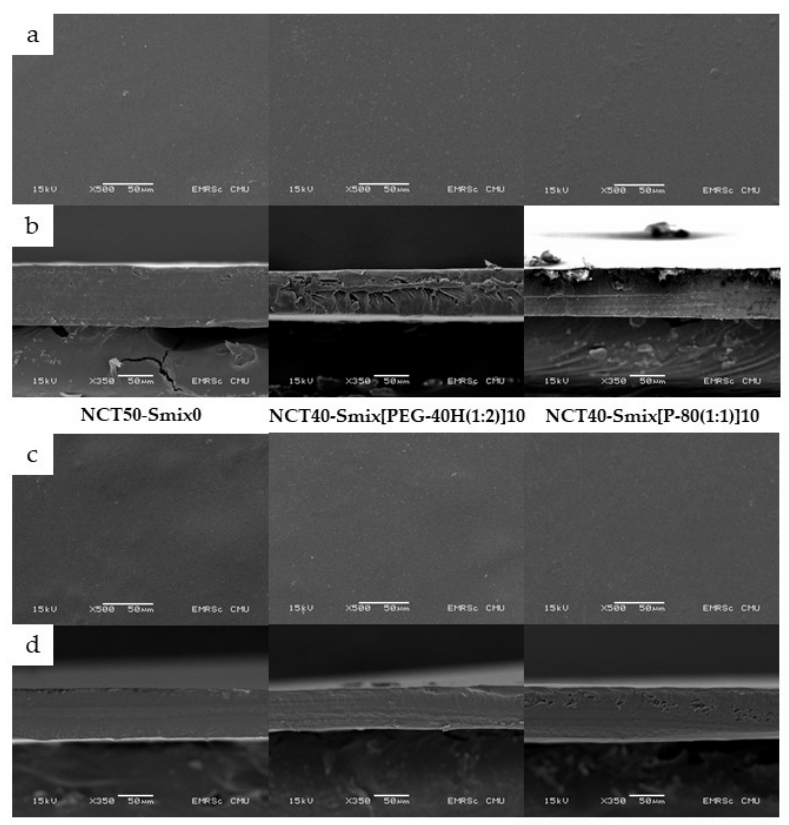
Figure 2. Scanning electron microscopy (SEM) images of NCT-ME fast-dissolving films, at the